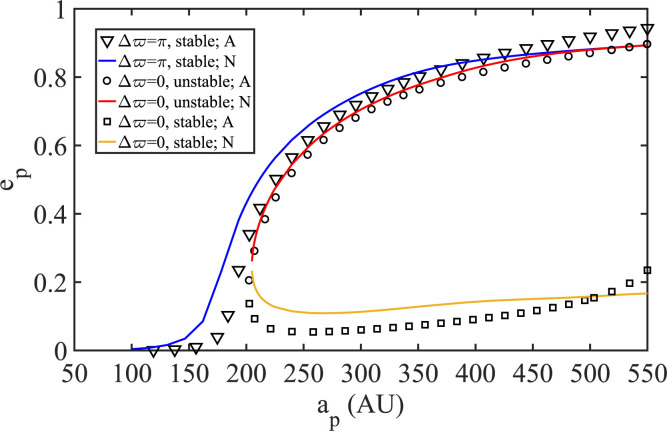
Comparison between the coplanar equilibrium families obtained via
orbit-averaged disk potential (A; Equation (4)) and orbit-averaged
harmonics (N; Equation (39) with
ip = 0) of the potential generated by
DM1 (Table 1). It is evident
that both treatments of the disk potential, when combined with that of
the giant planets, yield very similar equilibrium structure, including
stability and behavior as a function of semimajor axis.